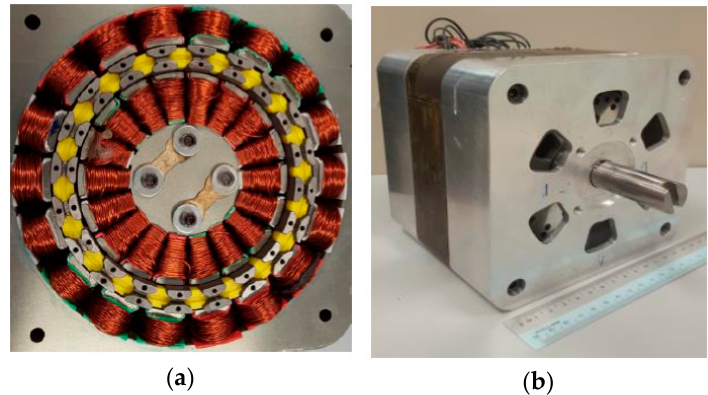
Figure 10. Prototype of DSSR-PMG, ( a ) Cross-sectional view; ( b ) Assembled DSSR-PMG.